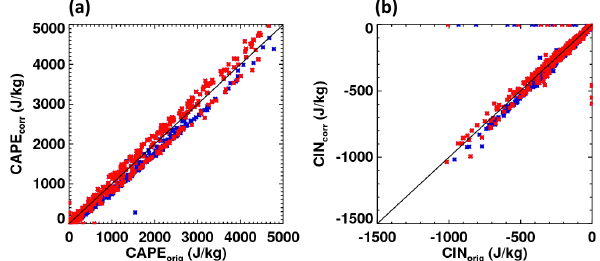
Figure 9. Scatterplots of convective indices comparing original (orig) and humidity-corrected (corr) soundings for (a) CAPE and (b) CIN. Daytime soundings (12:00–24:00UTC) are indicated with red markers while nighttime soundings are